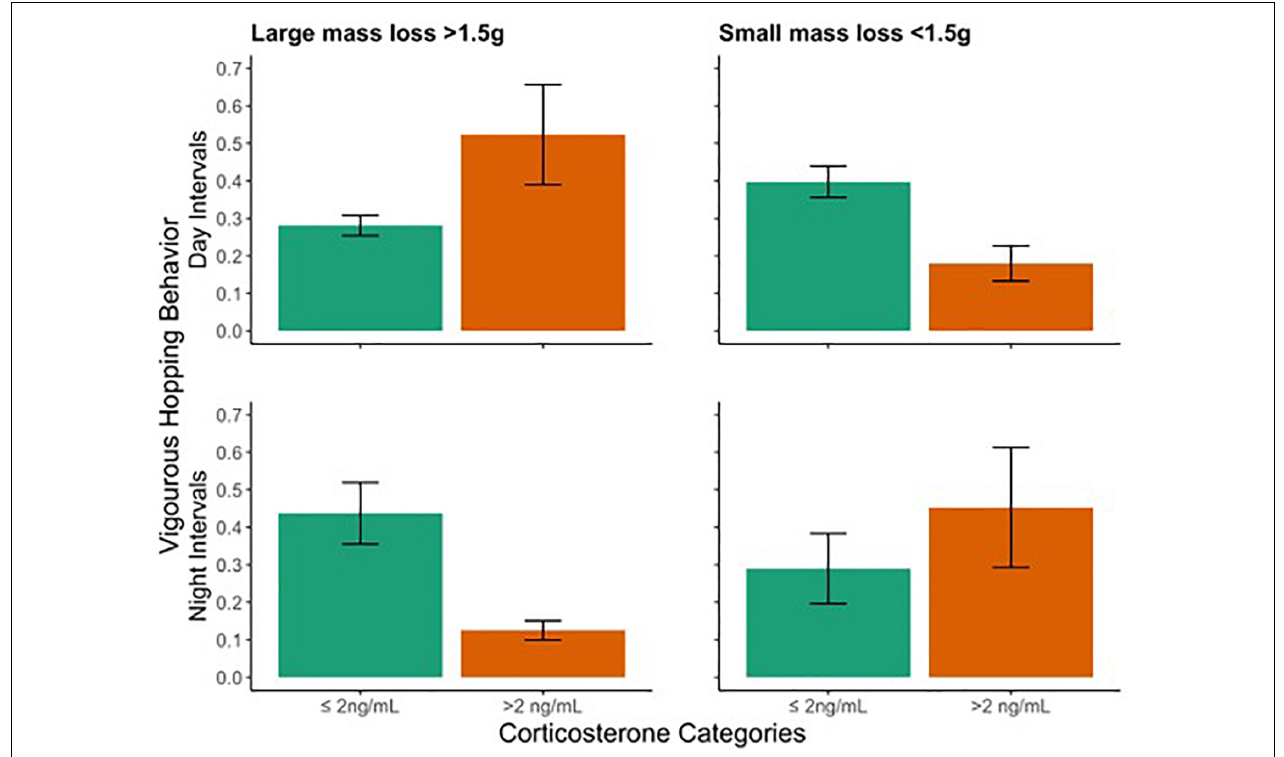
FIGURE 9 | Difference between day (top panels) and night (bottom panels) escape-type hopping behavior with regard to baseline corticosterone for binned categories of large (left) and small (right) mass loss. Bars show means ± SEM for each group. Activity data are displayed as a percent of intervals counted. While no significant effects or interactions relate nighttime activity to baseline corticosterone, overall trends are opposite to the significant interaction between daytime activity, weight change, and